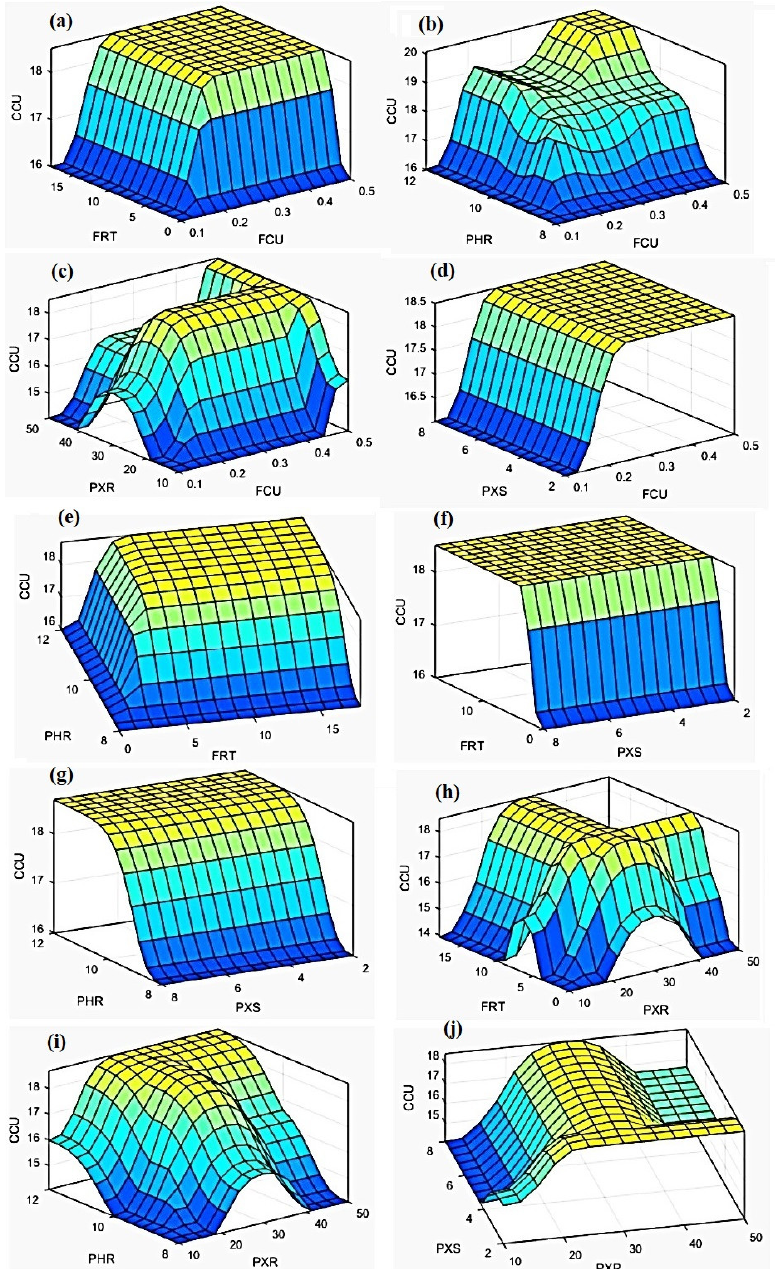
Figure 7. Resulting response surfaces of the PMM model—dependence of final concentrate quality (CCU) on input parameters. ( a ) copper content in the feed (FCU) and frother consumption (FRT); ( b ) copper content in the feed (FCU) and pH value of slurry at rougher flotation circuit (PHR); ( c ) copper content in the feed (FCU) and collector consumption at rougher flotation circuit (PXR); ( d ) copper content in the feed (FCU) and collector consumption at scavenger flotation ciruit (PXS); ( e ) frother consumption (FRT) and pH value of slurry at rougher flotation circuit (PHR); ( f ) frother consumption (FRT) and collector consumption at scavenger flotation ciruit (PXS); ( g ) pH value of slurry at rougher flotation circuit (PHR) and collector consumption at scavenger flotation ciruit (PXS); ( h ) frother consumption (FRT) and collector consumption at rougher flotation circuit (PXR); ( i ) pH value of slurry at rougher flotation circuit (PHR) and collector consumption at rougher flotation circuit (PXR); ( j ) collector consumption at scavenger flotation ciruit (PXS) and collector consumption at rougher flotation circuit